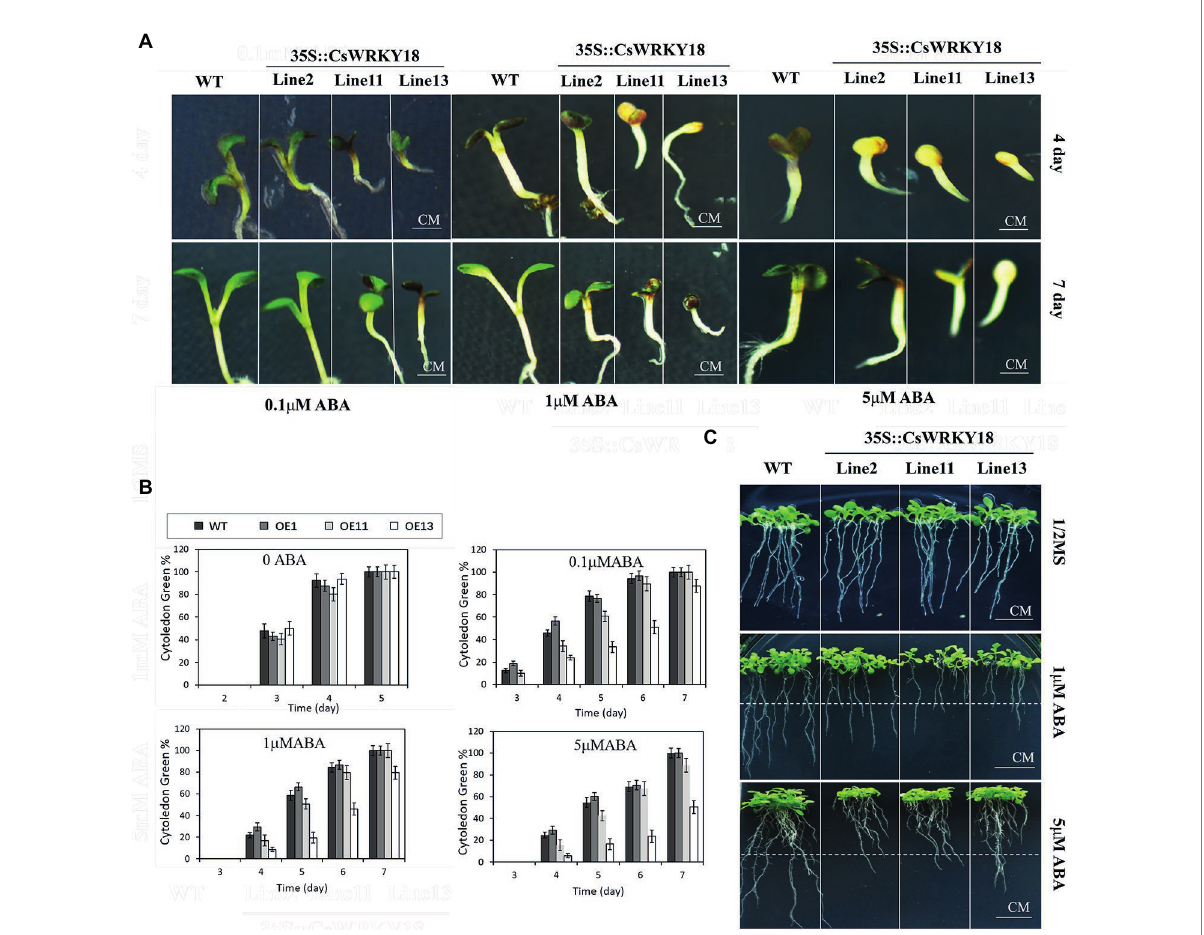
FIGURE 7 35S:: CsWRKY18 seedlings development under ABA treatment. (A) Seedling development of wild-type and 35S:: CsWRKY18 treated with 0.1, 1, and 5 μ M ABA. (B) Cytoledon green ratio of seedlings under ABA treatment. (C) Root elongation of wild-type and 35S:: CsWRKY1